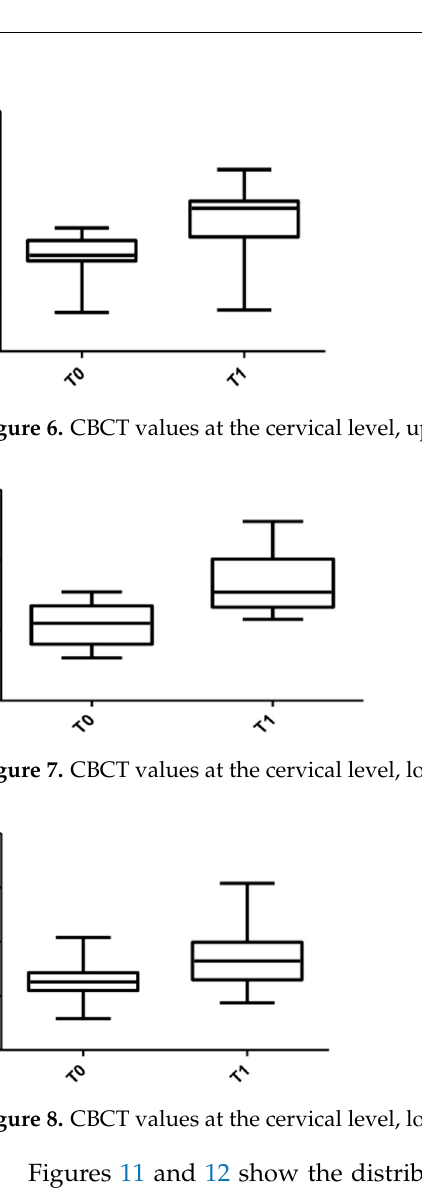
Figure 5. Cone Beam Computer Tomography values at the cervical level, upper arch, at T0 and T1 for females .